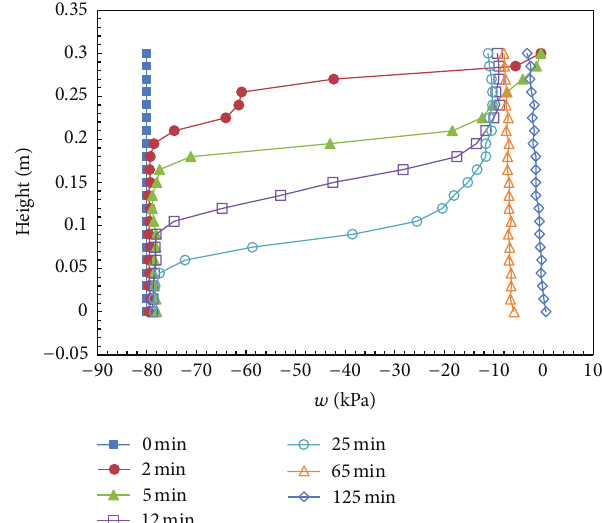
Figure 13: Variation of pore water pressure with time along Section AA 󸀠 .